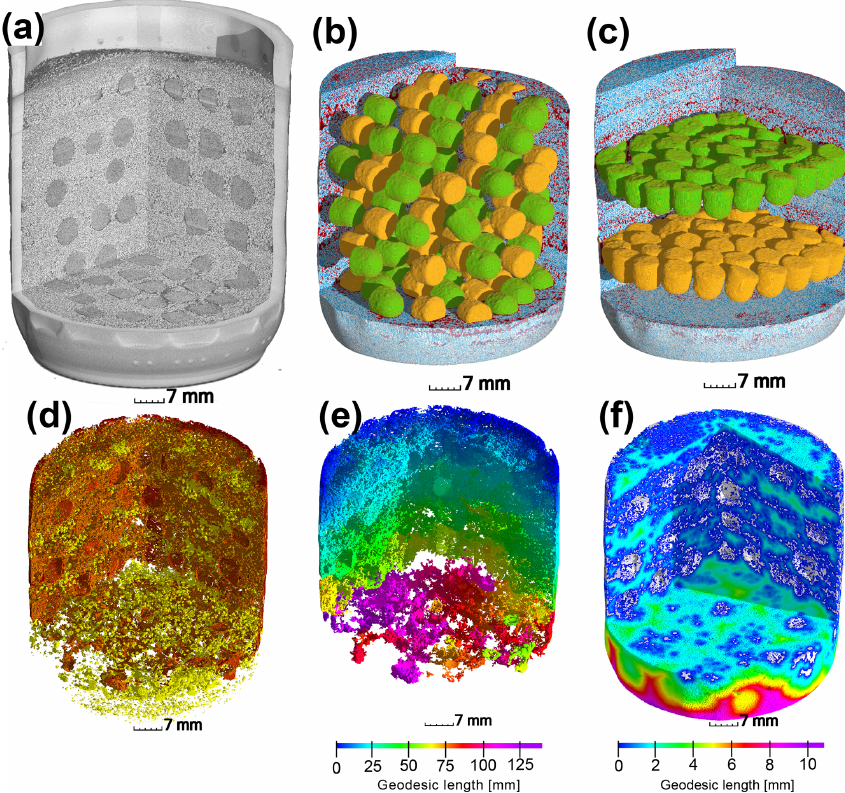
Figure 1. Upper row: (a) X-ray CT scan of an incubation jar with random hotspot architecture and medium saturation (60%WFPS). (b) Im- age segmentation of the same jar into air (red), water (blue), sand (transparent), A. tumefaciens hotspots (orange) and P. denitrificans hotspots (green). (c) A different jar at medium saturation (60%WFPS) with layered Pd–At hotspot architecture. Lower row: a jar with random dis- tribution at high saturation (90%WFPS). (d) Air connectivity, determined as the volume fraction of air connected to the headspace (red, disconnected air shown in yellow). (e) Air tortuosity as derived from the geodesic length to the headspace within the connected air cluster. (f) Diffusion lengths determined as the geodesic length to the closest connected air cluster (white) within water-filled